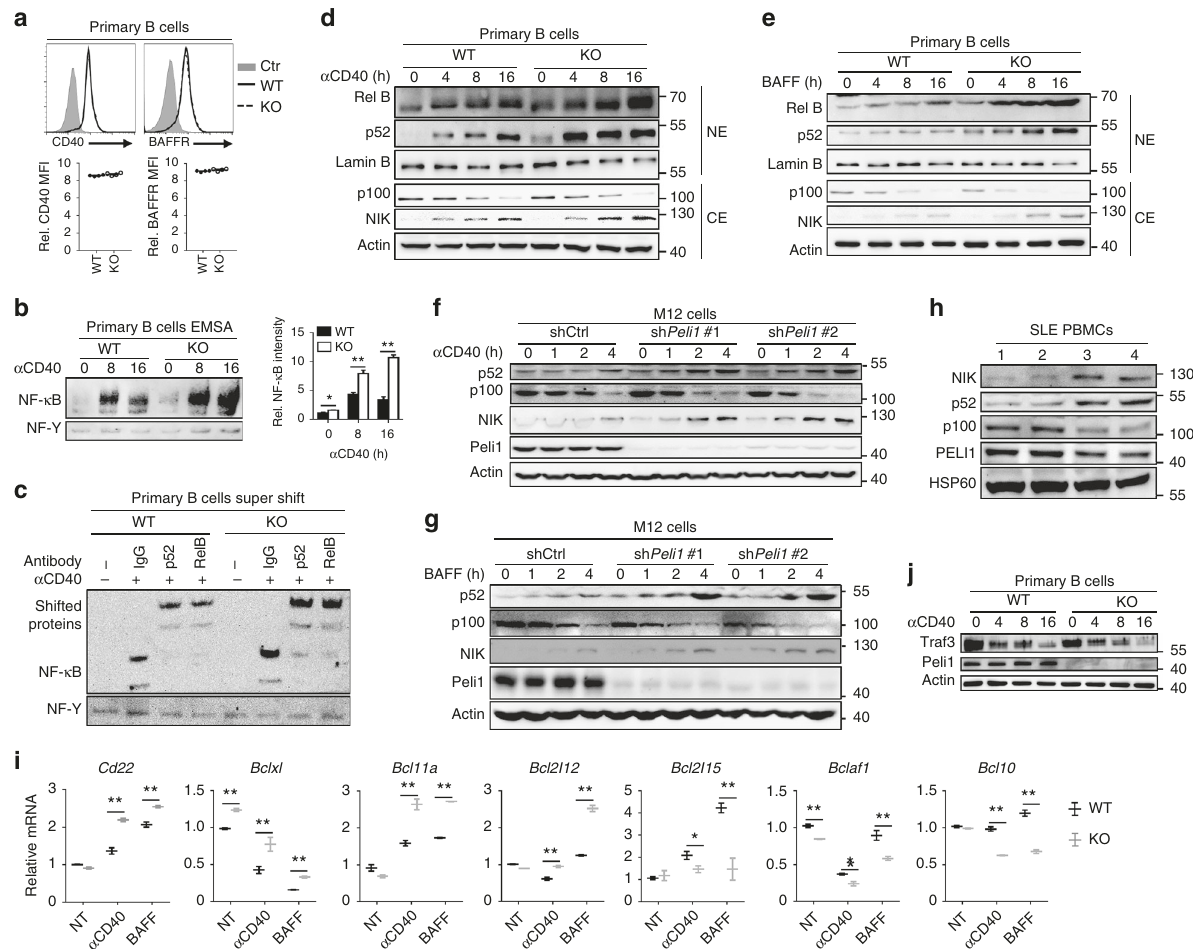
Fig. 4 Peli1 is a pivotal negative regulator of noncanonical NF- κ B pathway. a Flow cytometry analysis of the surface expression of CD40 and BAFF receptor (BAFFR) in WT and KO splenic B cells. Data are presented as the representative FACS plots (upper panel) and summary graphs (lower panel). Ctr represents isotype control. MFI = mean fl uorescence intensity. b Electrophoretic mobility-shift assay (EMSA) of nuclear extracts of WT and KO splenic B cells that left unstimulated or stimulated for 8, 16 h with anti-CD40 ( α CD40, 1 µ g/ml). Data are presented as the immunoblot panels (left) and the bar graph to quantify the relative NF- κ B signals (right). c Supershift assay determining the NF- κ B complex in the nuclear extracts of WT and KO splenic B cells that left unstimulated or stimulated for 16 h with anti-CD40 ( α CD40, 1 µ g/ml) by using the control antibody (IgG), anti-p52, or anti-RelB antibody. d , e Immunoblot analysis of NF- κ B proteins, NIK or Actin and lamin B (loading controls) in cytoplasmic extracts (CE) and nuclear extracts (NE) of B cells stimulated with anti-CD40 ( α CD40) ( d ) or BAFF ( e ). f , g Immunoblot analysis of the effect of Peli1 knockdown on NIK and NF- κ B p100/p52 protein levels in total lysis of M12 cells that stimulated with anti-CD40 ( α CD40) ( d ) or BAFF ( e ). h Immunoblot analysis of NIK, p52, p100, Peli1, and HSP60 (loading control) expression in PBMCs of 4 SLE patients. i QPCR determining the relative expression of the indicated apoptosis-related genes in WT and Peli1 - di fi cient splenic B cells that left untreated (NT) or stimulated with BAFF or anti-CD40 ( α CD40) for 20 h. Data were normalized to a reference gene, Actin . Data are shown as the mean ± SEM based on three independent experiments. Two-tailed Student ’ s t- tests were performed. * P < 0.05 and ** P < 0.01. j Immunoblot analysis of Traf3 protein levels in WT and KO splenic B cells that stimulated for different time point with anti-CD40 ( α